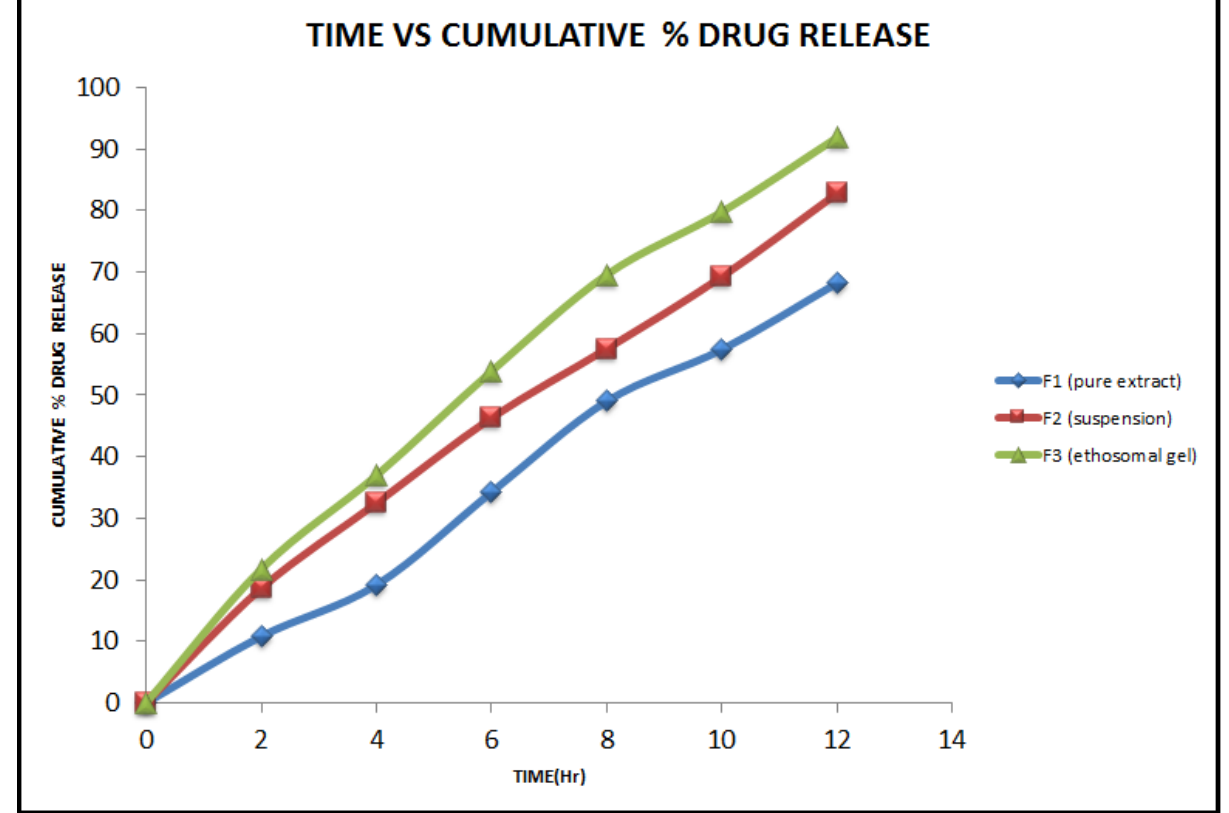
Figure 7. Comparative study of drug release of β -sitosterol from P. granatum extract, suspension, and gel.